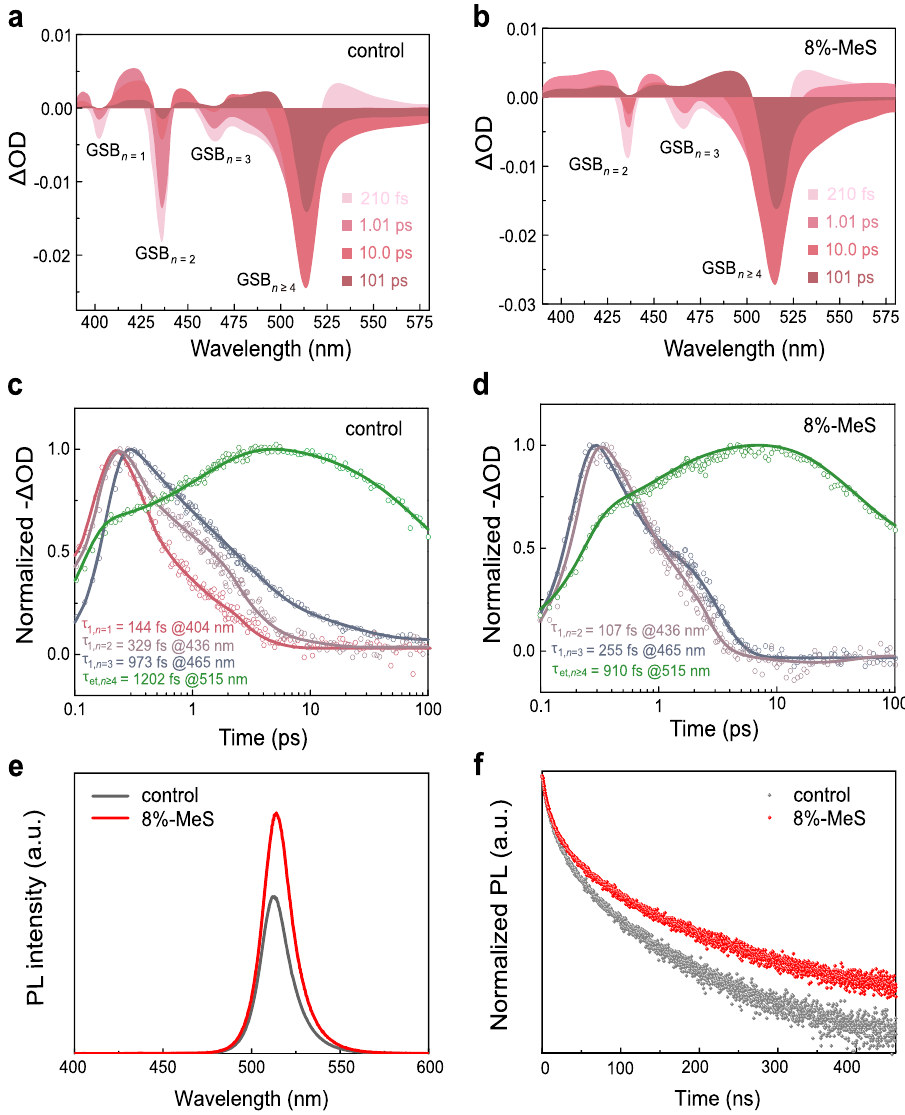
Fig. 3 TA spectra and PL characteristics of quasi-2D perovskite fi lms. a , b TA spectra at selected timescales. c , d TA kinetics traces probed at a different wavelength for the control ( a , c ) and MeS-treated perovskite fi lms ( b , d ), respectively (excited at 365 nm). e Steady-state PL spectra and f TRPL decay of the control (emission wavelength: 512 nm) and MeS-treated perovskite fi lm on glass substrates (emission wavelength: 514 nm) excited at 365